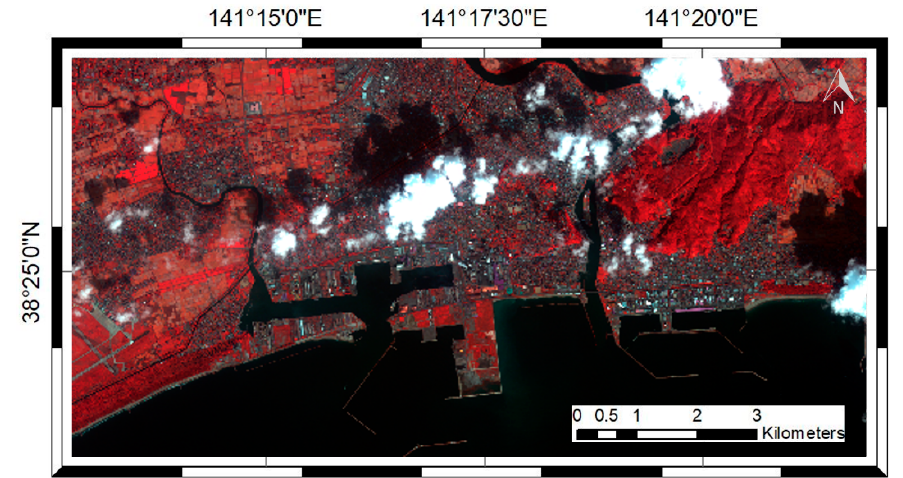
Figure 4. False color image of KOMPAT-2 data on 1 October 2009. NIR, green, blue images are assigned to the RGB channel.